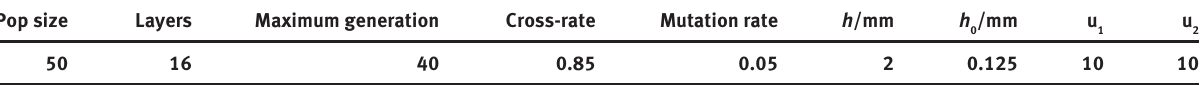
Table 3 Parameters used for numerical